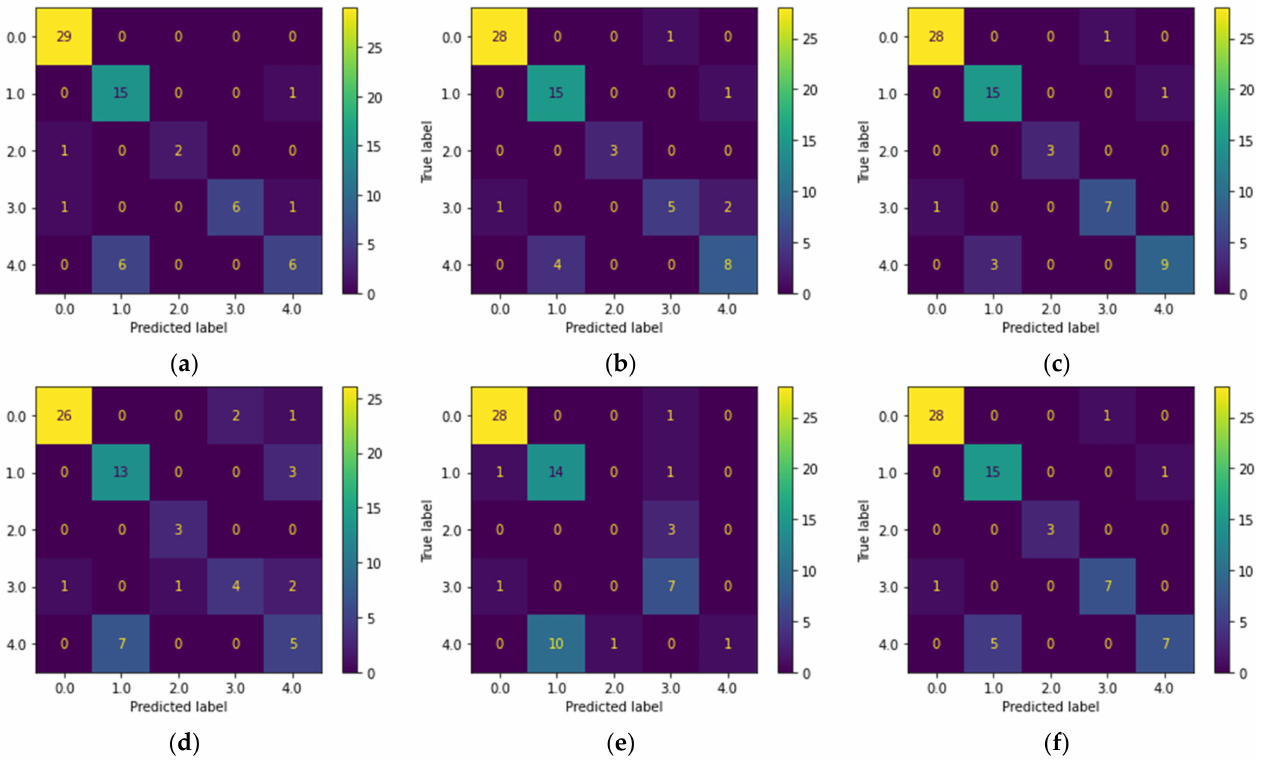
Figure 6. Confusion matrices showing the performance of ( a ) LR, ( b ) LDA, ( c ) KNN, ( d ) CART, ( e ) NB, and ( f ) SVM algorithms. Labels 0–4 correspond to “fist” (0), “flat” (1), “okay” (2), “rock” (3), and “victory” (4) hand gestures. Table 2. Classification report for the performance of the six investigated machine learning algorithms. Algorithm